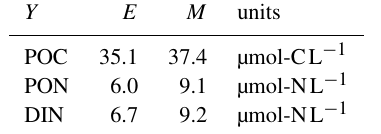
Table E1. Cumulative residuals for PeECE III. Y